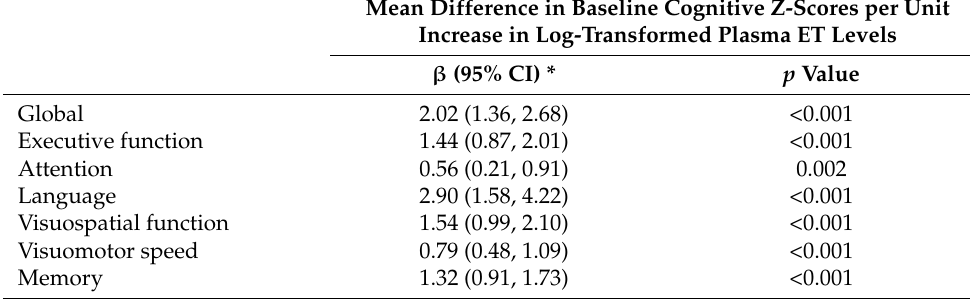
* Linear regression models with mean differences ( β ) and 95% CI were used for log-transformed plasma ET levels as a continuous independent variable. All values were adjusted for age, gender, education, APOE ε 4 status, hypertension, diabetes, and cardiovascular disease. Interpretation: significant β ( p < 0.05) indicates an increase in cognitive z-scores based on the β value for every 10-fold (1 unit of log 10 [plasma ET]) increase in plasma ET levels at baseline. Abbreviations: CI = confidence interval, ET =